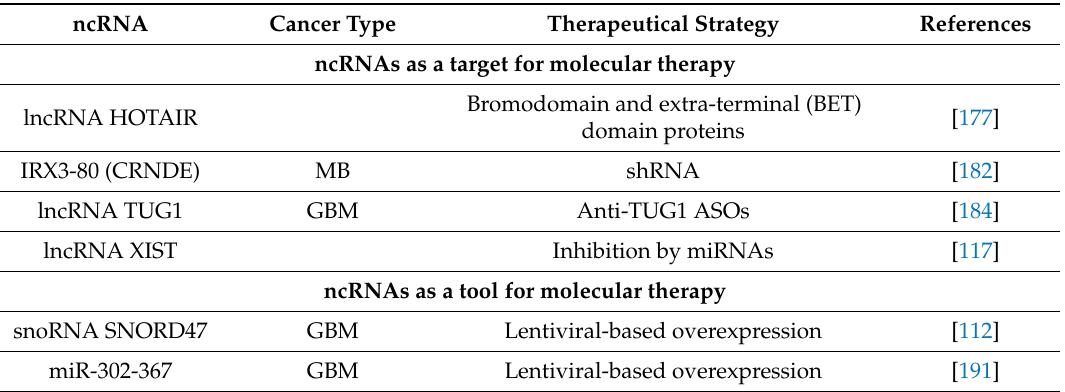
Table 5. NcRNAs as a therapy